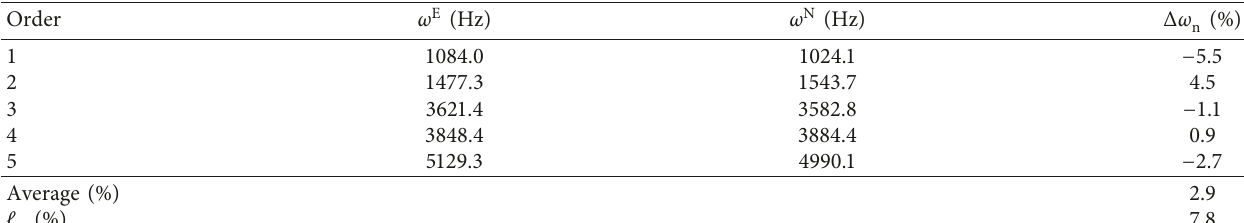
Table 4: Correlation between the numerical and experimental natural frequencies, for the stator model with the equivalent volume of the winding.